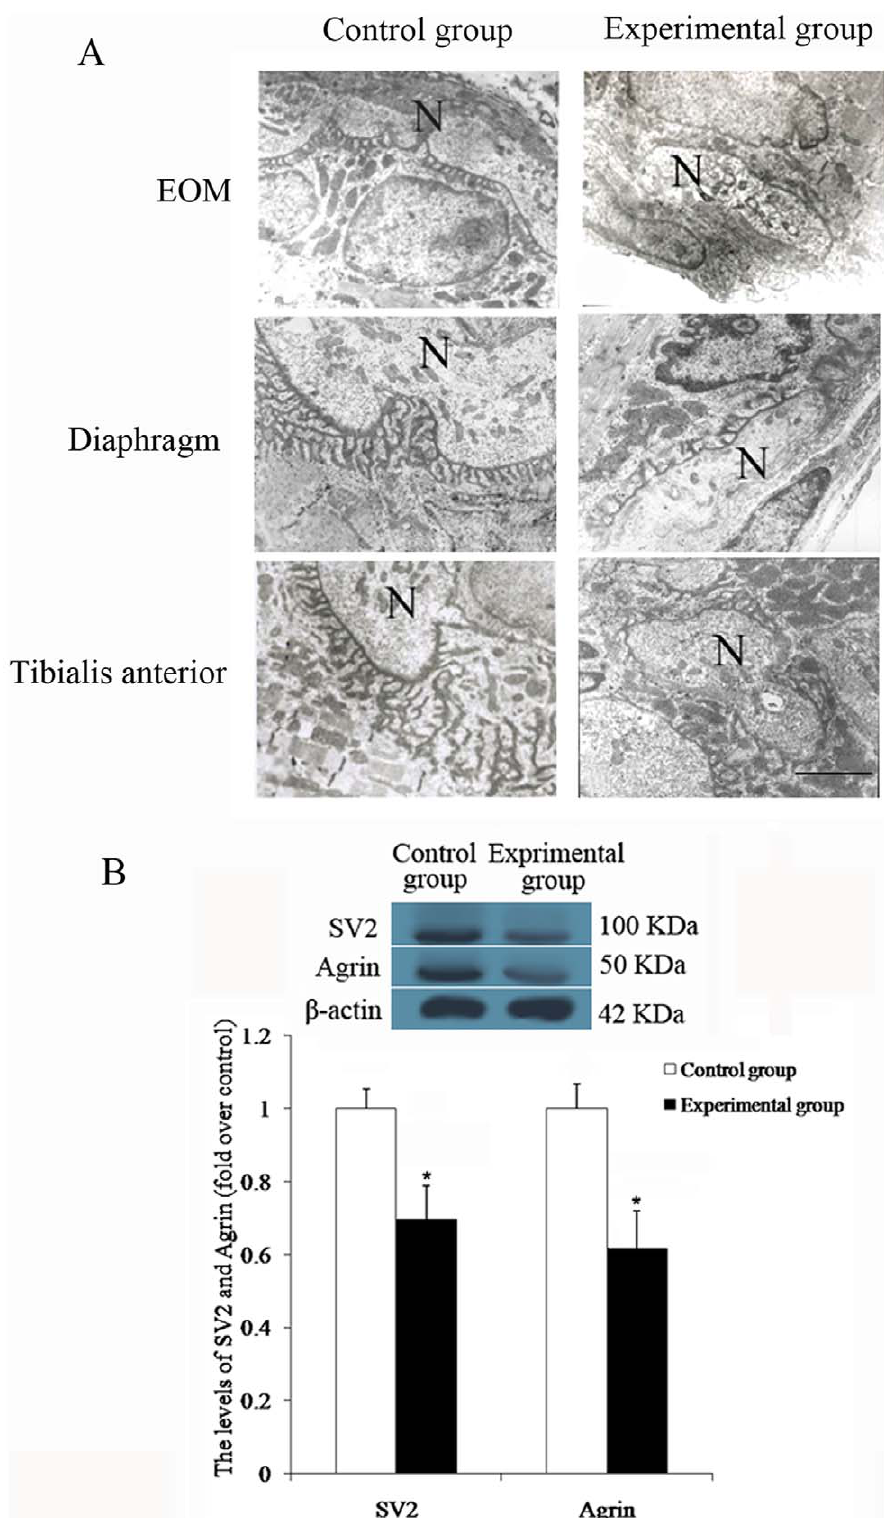
Figure 7. The diversity of the neuromuscular junction in three muscles in the two groups. A. Ultrastructure of the neuromuscular junction (N=nerve endings). B. Western blot analysis for Agrin and SV2 levels in EOM. *Significant ( P , 0.05) difference between the control and experimental groups determined by independent two-sample t test. Scale bar=5 m m.